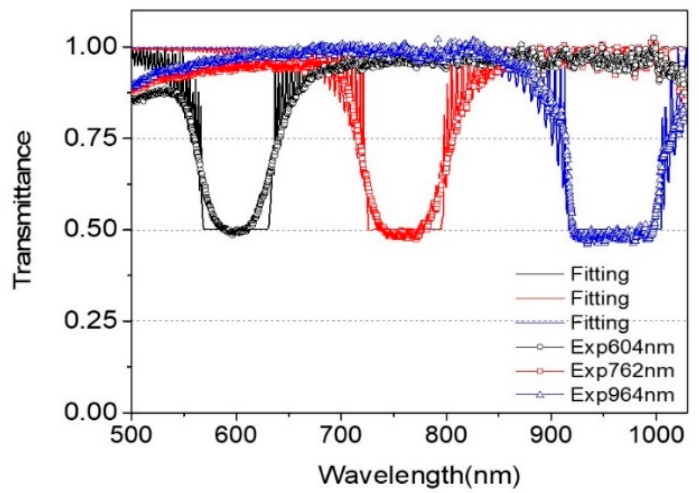
Figure 12. Experimentally measured three PBG data and their theoretical fitting data (solid lines) of the R-PCLC1 cell with three PBG center wavelength positions: λ B = 600 nm (o), 762 nm ( □ ), and 964 nm ( △ ). Table 2. Optical constants of three PBGs of the R-PCLC1 cell with the center wavelength position of 600 nm, 762 nm, and 964